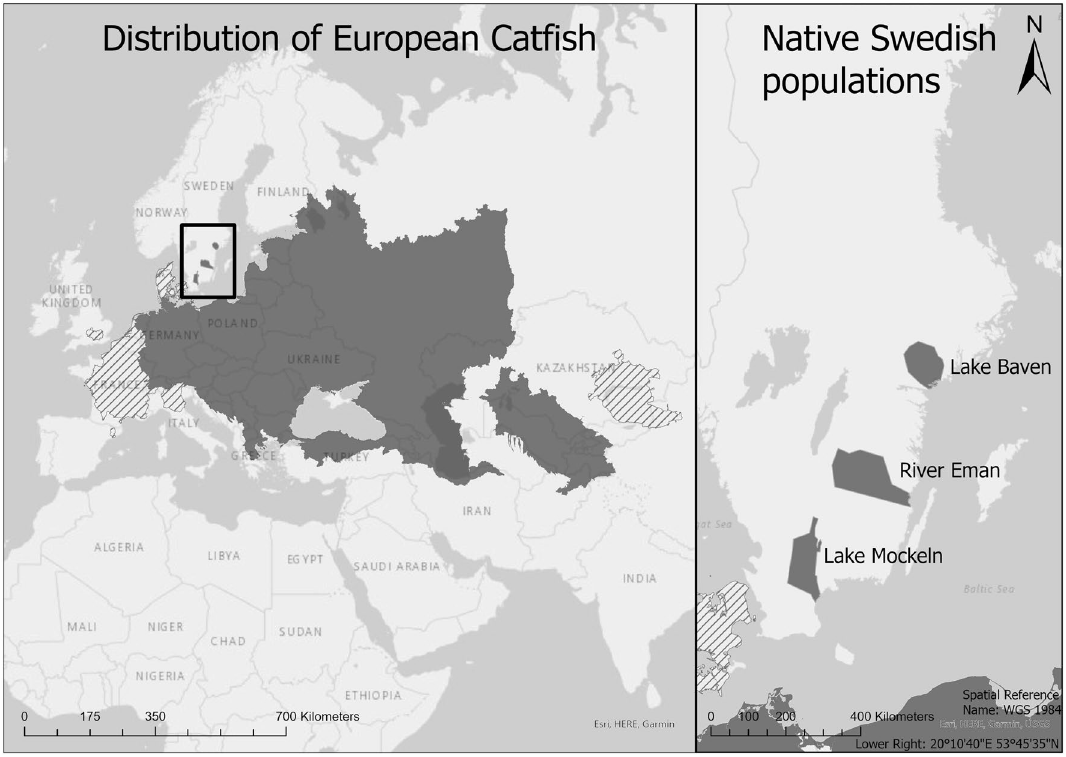
Figure 1. Map showing the distribution of European Catfish, native populations in dark grey and introduced in striped. Redrawn from IUCN 17 , map created in ArcGIS software by Esri (ArcGIS Pro 2.7.1 https:// arcgis.